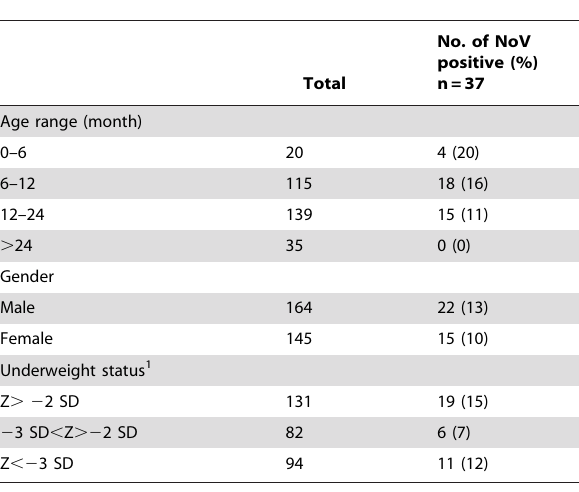
Table 2. Epidemiological profile of pediatric norovirus diarrhea in children of # 5 years of age from Ouagadougou, Burkina